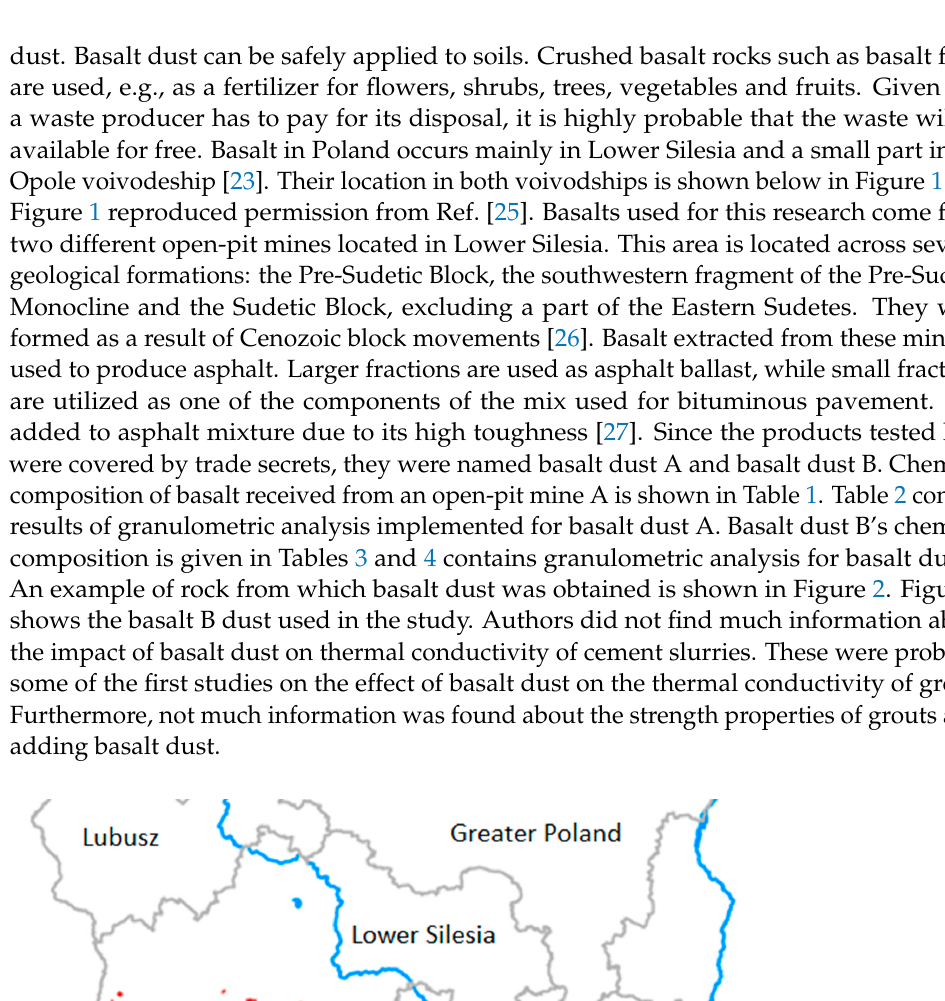
Figure 3. Basalt dust (photo by K. Se ń czuk). Table 1. Basalt A chemical composition. Composition